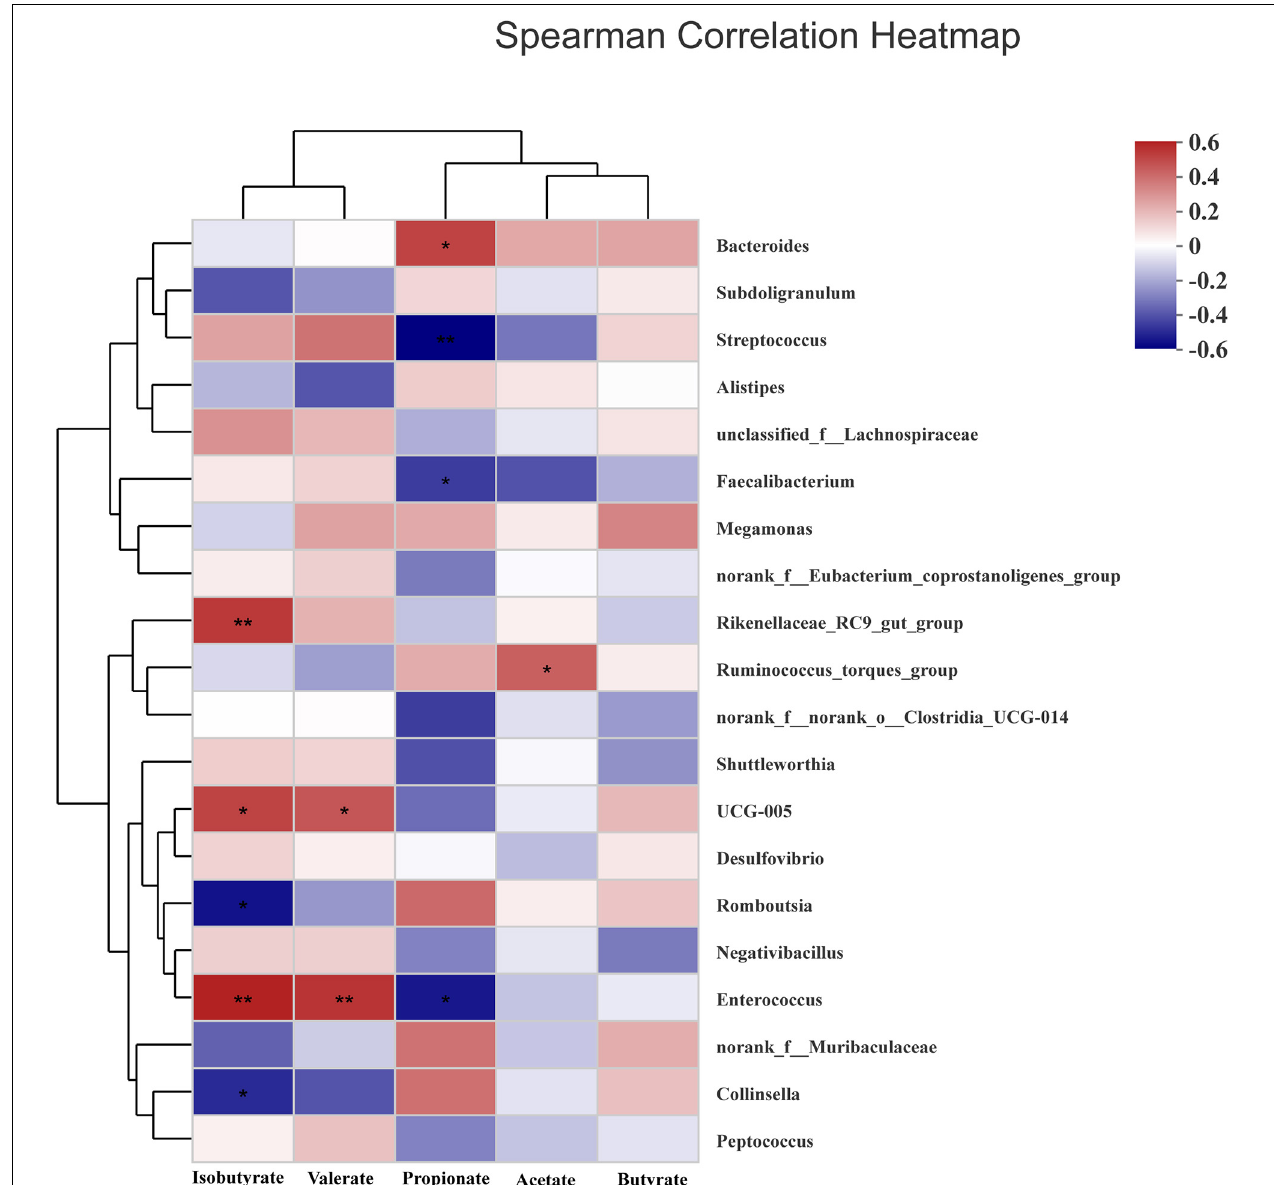
FIGURE 7 | Heatmap of spearman’s correlation between cecal microbiota at genus level and SCFAs including acetate, propionate, butyrate, isobutyrate, and valerate in the cecum of White Pekin ducks on day 35. Significant correlation was recorded by 0.01 < P ≤ 0.05*, 0.001 < P ≤ 0.01**, P ≤ 0.001***.